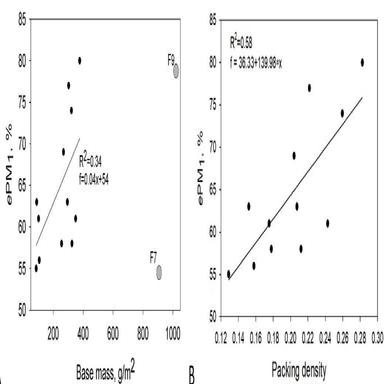
Effects of base mass (A) and packing density (B) on ePM1.